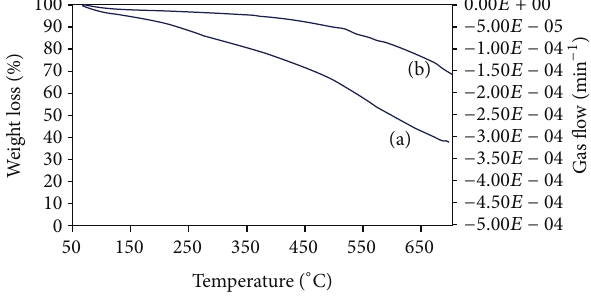
Figure 5: TGA thermogram analysis of (a) TiO 2 /PANi and (b) TiO 2 /AC